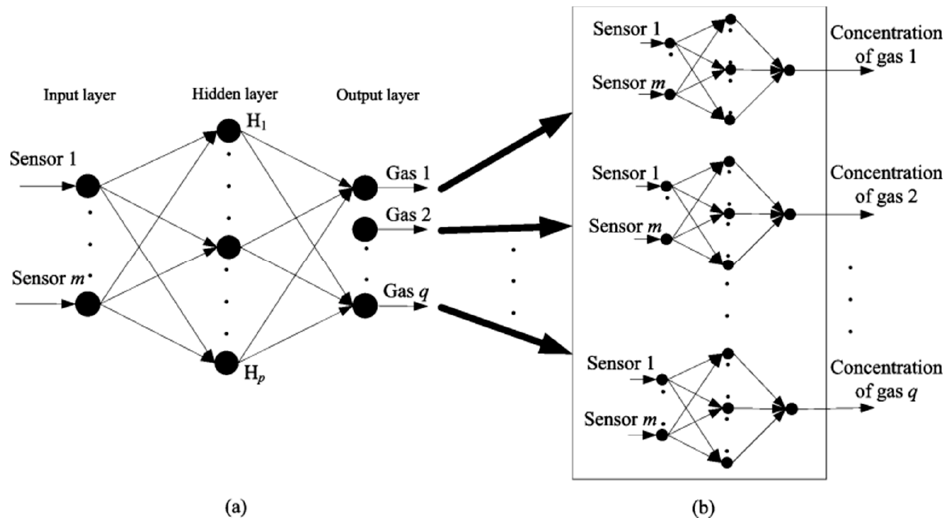
Figure 10. Structure of ( a ) SMIMO- and ( b ) MMISO-based MLP concentration estimation models